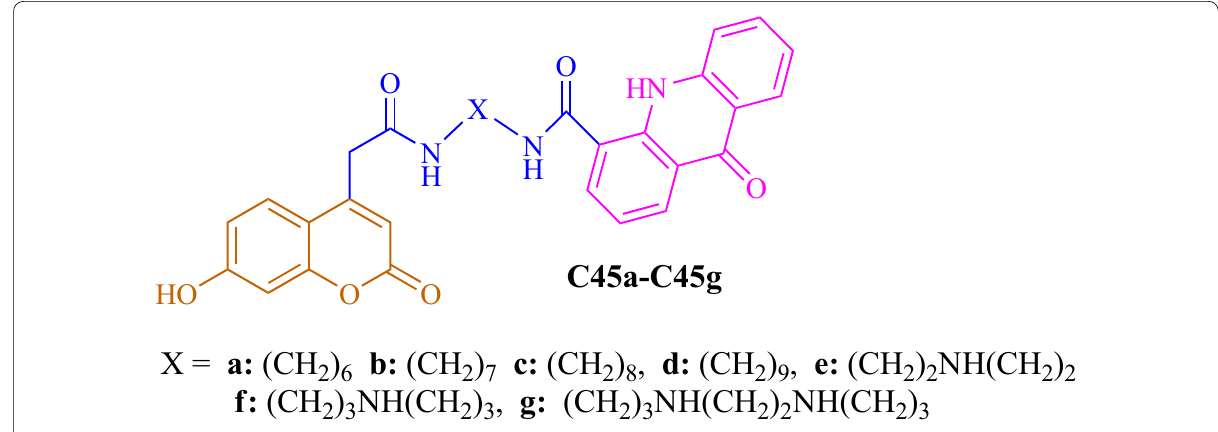
Fig. 46 Structures of synthesized of acridine-coumarin hybrids C45a – C45g